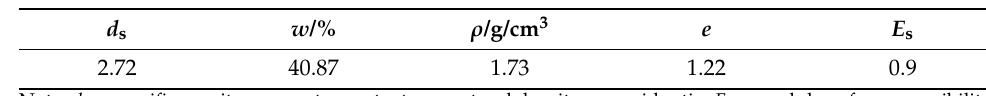
Figure 1. Sampling and test sites climatic conditions. Table 1. Soil parameters in laboratory tests.